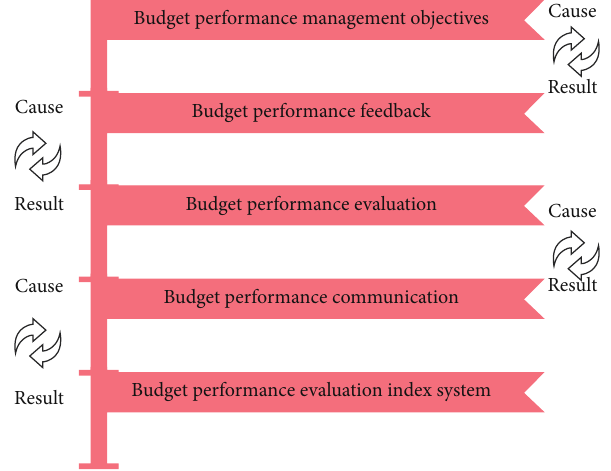
Figure 7: Schematic diagram of the causal chain of the budget performance management